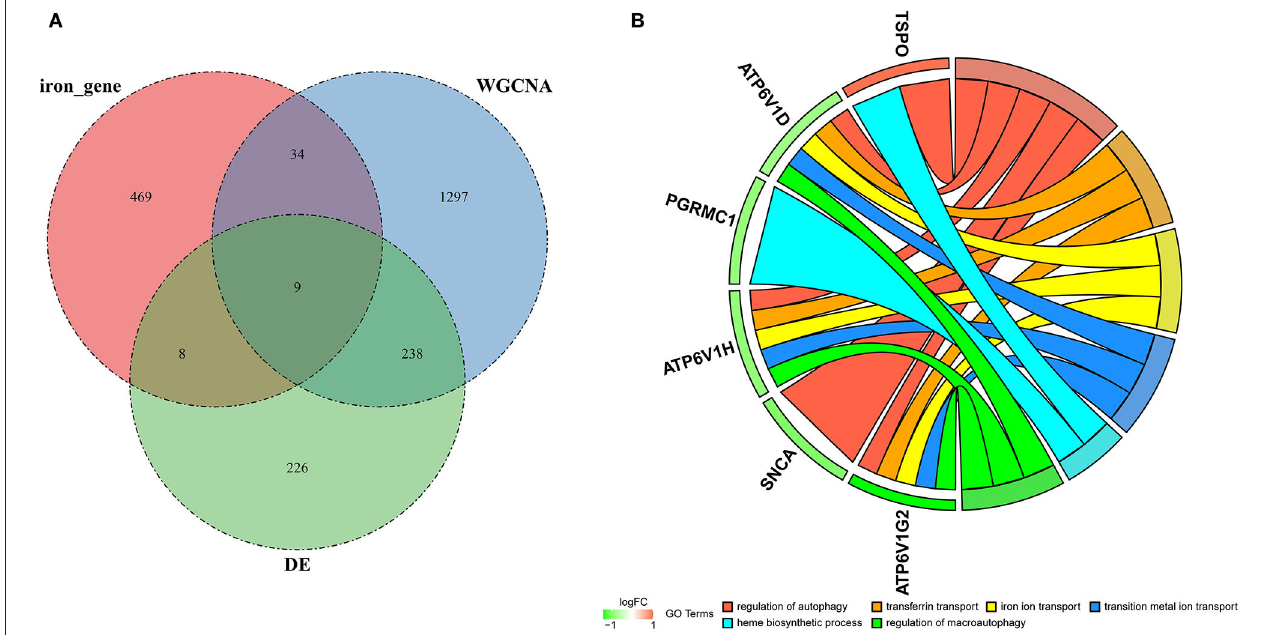
FIGURE 4 | Hub genes and GO analysis. (A) Nine hub genes were obtained by taking the intersections of the DEGs, MEturquoise module genes of the WGCNA, and iron metabolism-related genes. (B) Biological processes in which the hub genes were involved.